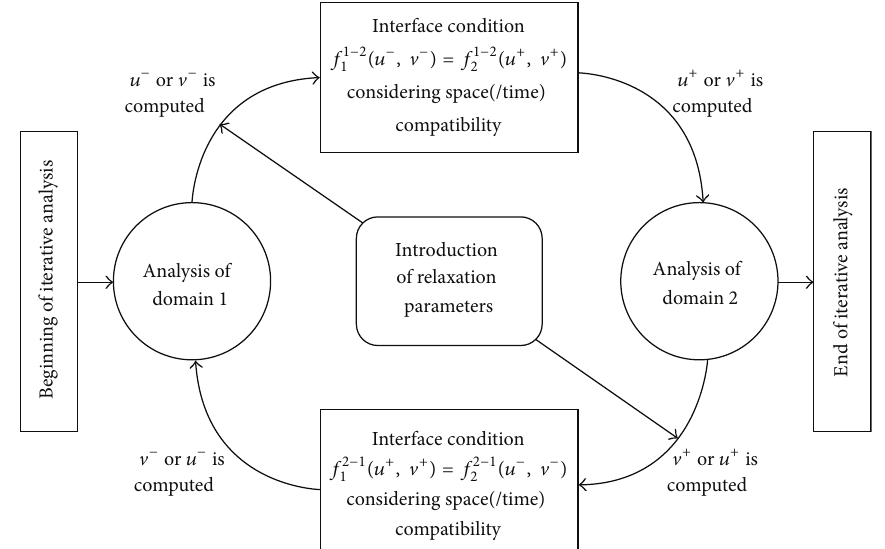
Figure 1: Sketch of the iterative coupling algorithm.